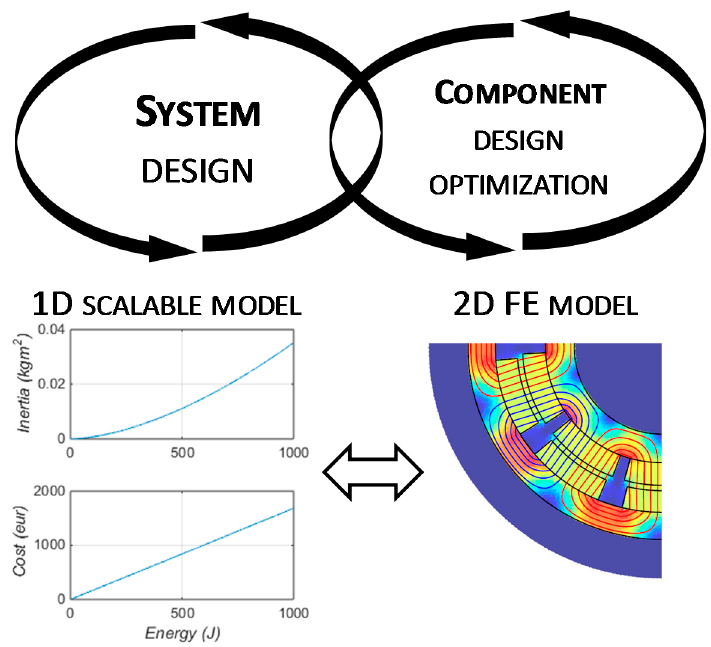
Figure 2. The co-dependent nature of the system design and component design cycles through linked modelling approaches.